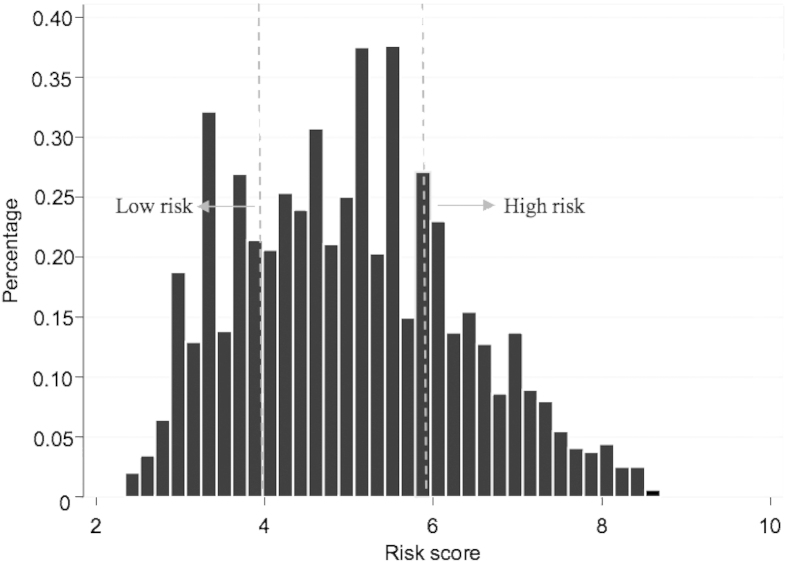
Distributions of risk score of silicosis calculated with a linear combination of the selected predictors weighted by the Cox regression coefficient.Note: low risk group (risk score < 3.97), high risk group (risk score >= 5.91).